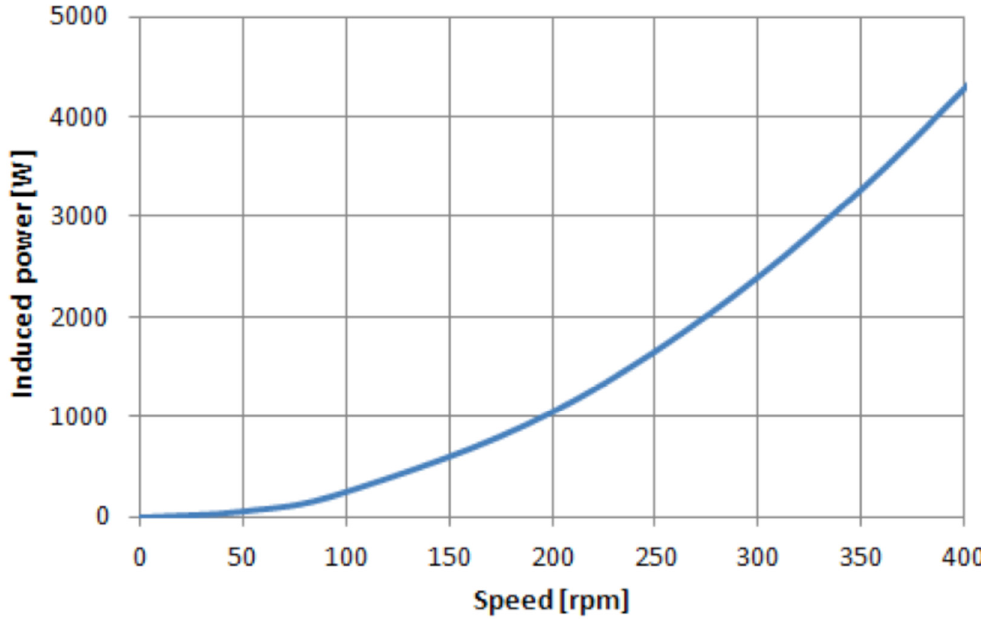
Fig. 5. Power – speed curve of